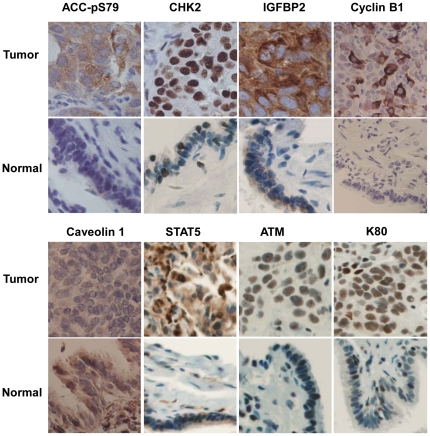
Examples of aberrant expression of 8 molecules in tumor tissue.Increased expression of ACC-pS79, CHK2, IGFBP2, cyclin B1, STAT5, ATM, and Ku80, and decreased expression of caveolin 1 in tumor tissues were compared with normal tissues from the same cases shown withconsistent with findings yielded by RPPA and Western blot analyses. 40× Magnification.